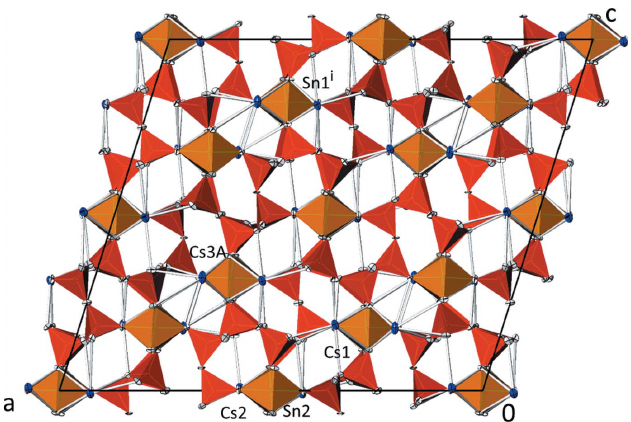
Figure 1 The crystal structure of Cs 2 SnSi 6 O 15 in a projection along [010]. Cs sites are given in blue, [SnO 6 ] octahedra in orange and SiO 4 tetrahedra in red. Displacement parameters are drawn at the 74% probability level. For clarity, the disordered Cs3 site with minor occupancy (Cs3 B ) is not shown. [Symmetry code: (i) x , y + 1, z +